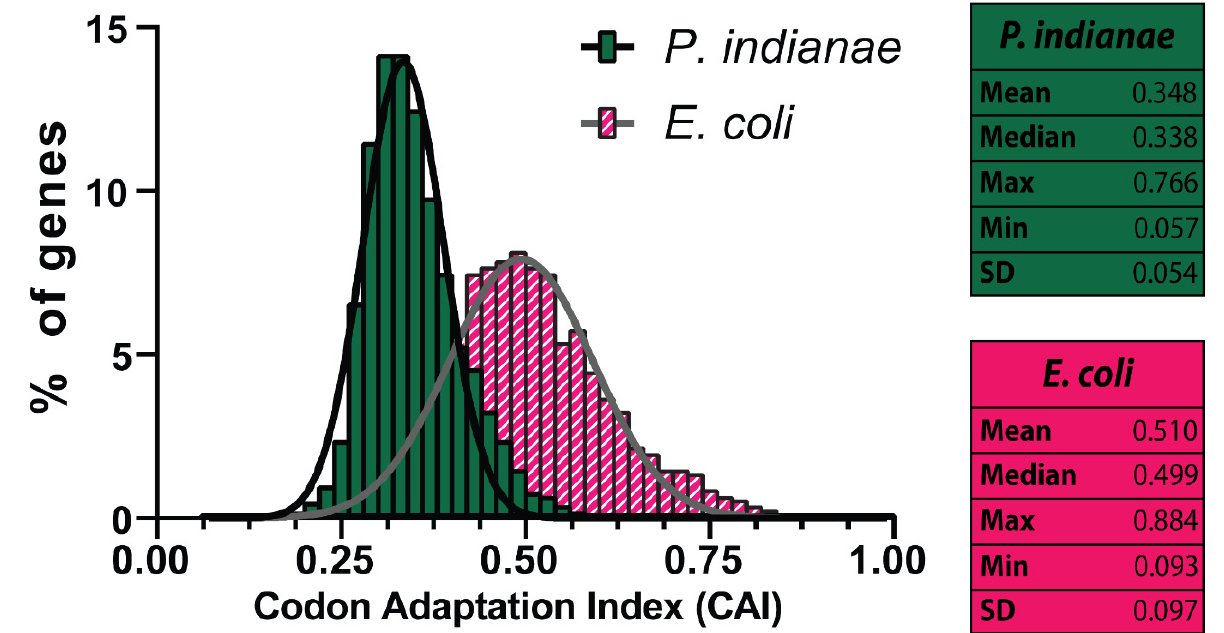
Figure 1. Distribution of Codon adaptation index (CAI) scores for P. indianae and E. coli genes with respect to their fitness in E. coli . Mean, median, maximum, and minimum scores are reported for the distributions. Normal Gaussian distributions are shown for each. SD = standard deviation.